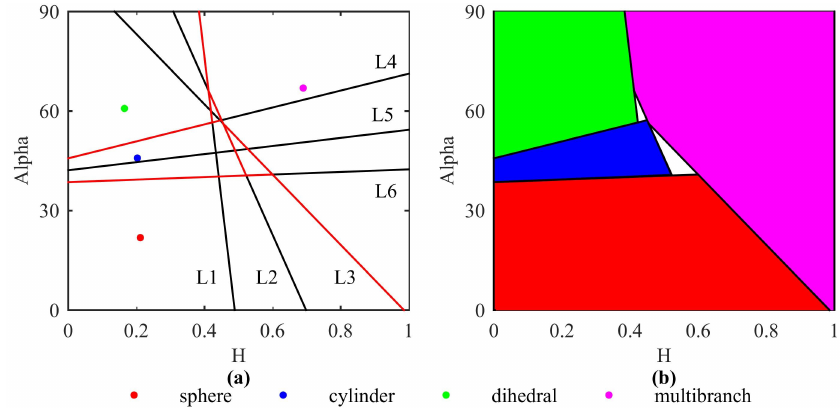
Figure 15. The real classification plane. (a) Lines that make contribution to the classification. (b) The real classification plane.